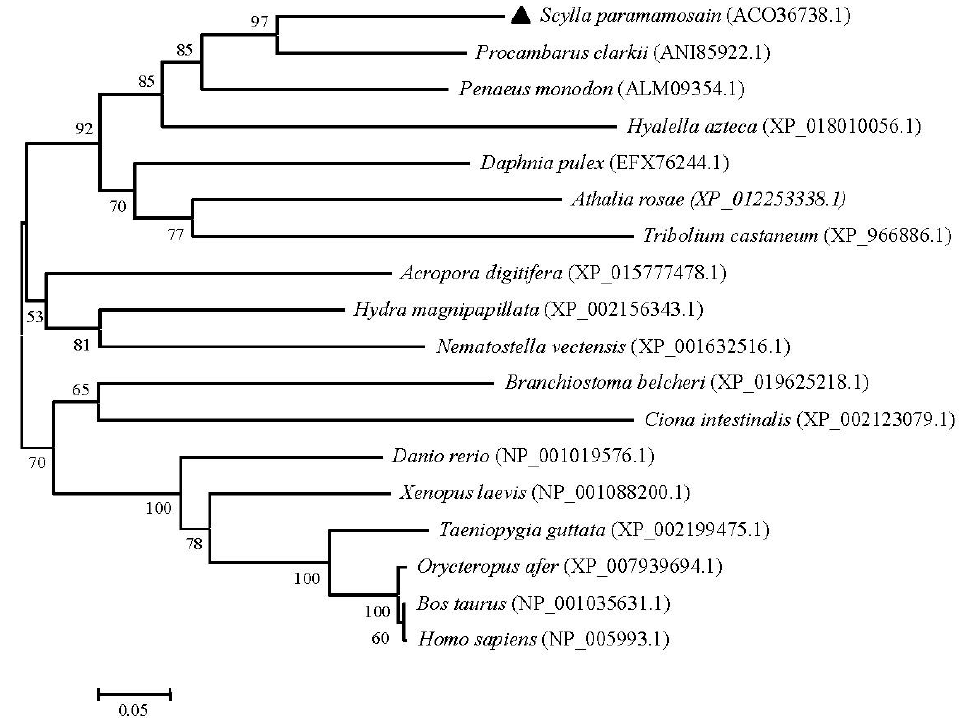
Figure 5. Phylogenetic tree of the UCHL3 amino acid sequences between S. paramamosain and other species. The GenBank codes of species are described in brackets. The Sp- UCHL3 is marked by black triangle. The numbers near the node mean bootstrap values of 1000 replicates.